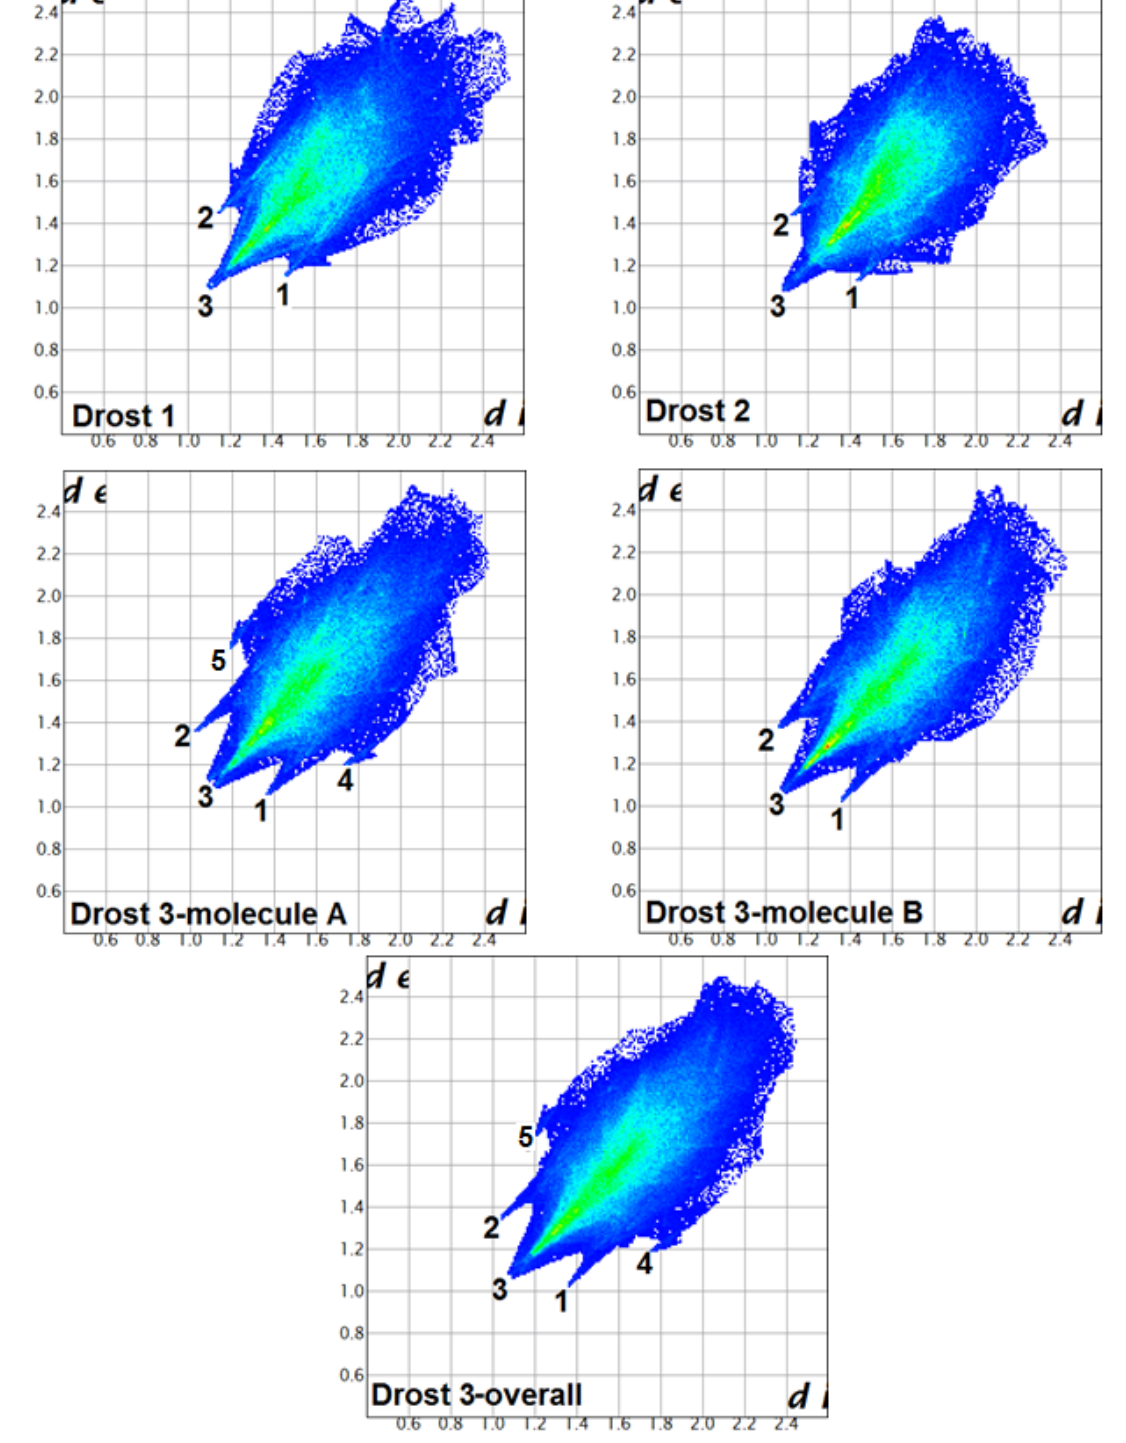
Figure 8. Fingerprint plots for studied compounds showing labelled close contacts O...H (1), H...O (2) and H...H (3), C…H (4), H…C